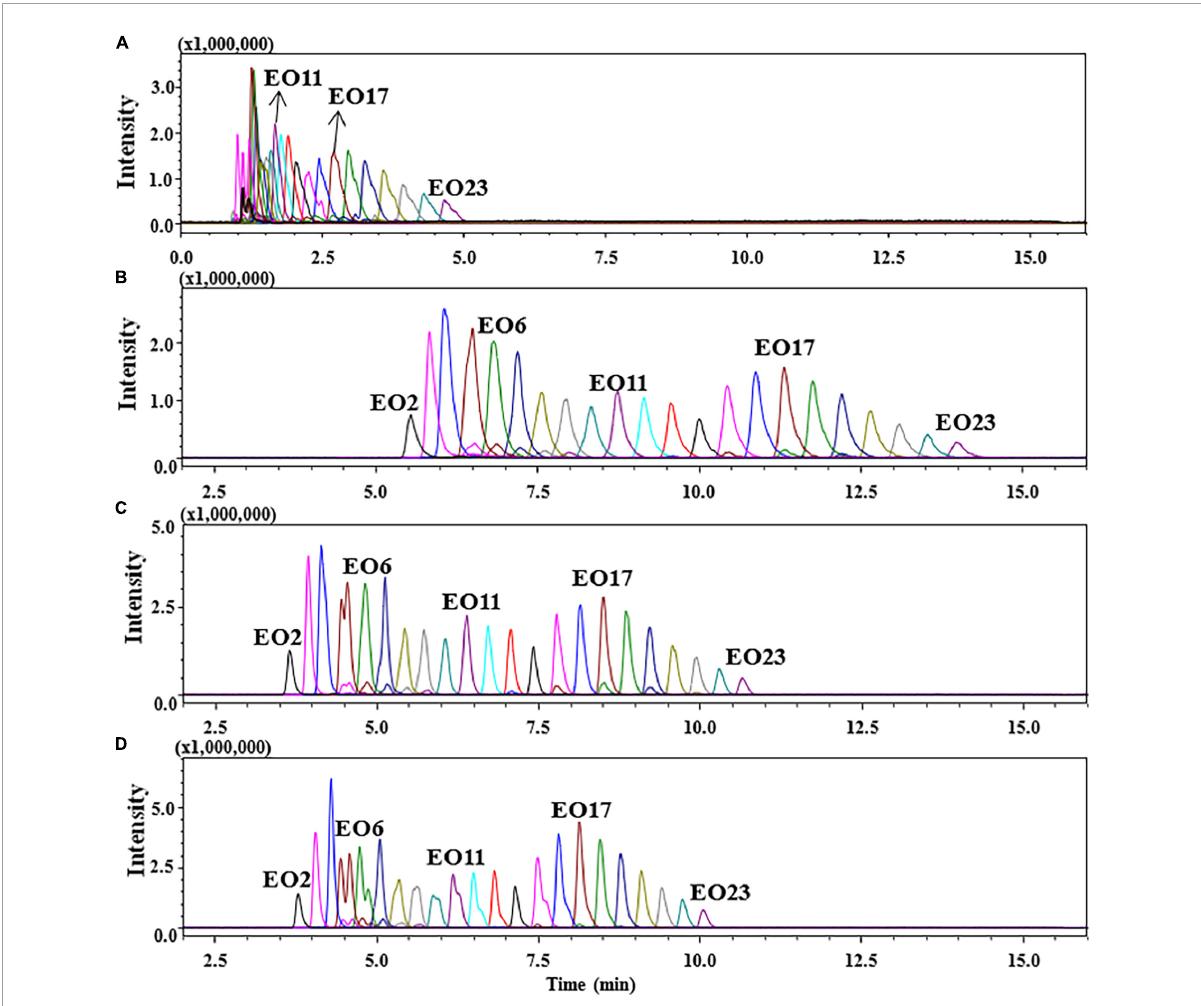
FIGURE2 Chromatograms of C16s spiked at POE-5 (1 mg/L) and POE-15 (5 mg/L) in different aqueous phases. (A) 0.2% formic acid in water, (B) 1 mM ammonium formate in water, (C) 10 mM ammonium formate in water, and (D) 2% formic acid and 10 mM ammonium formate in